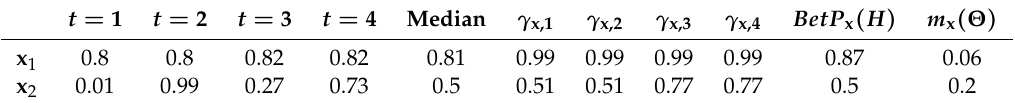
Table 2. Example of different values obtained sampling the posterior distribution with MC-dropout technique with T = 4, for two different pixels x 1 and x 2 , along with the corresponding discounting coefficient γ x , t obtained with Equation (7) setting α = 0.5. After having performed the conjunctive combination among the discounted BBAs, BetP x ( H ) and m x ( Θ ) results are shown for the two pixels x 1 and x 2 . t = 1 t = 2 t = 3 t = 4 Median γ x,1 γ x,2 γ x,3 γ x,4 BetP x ( H ) m x ( Θ ) x 1